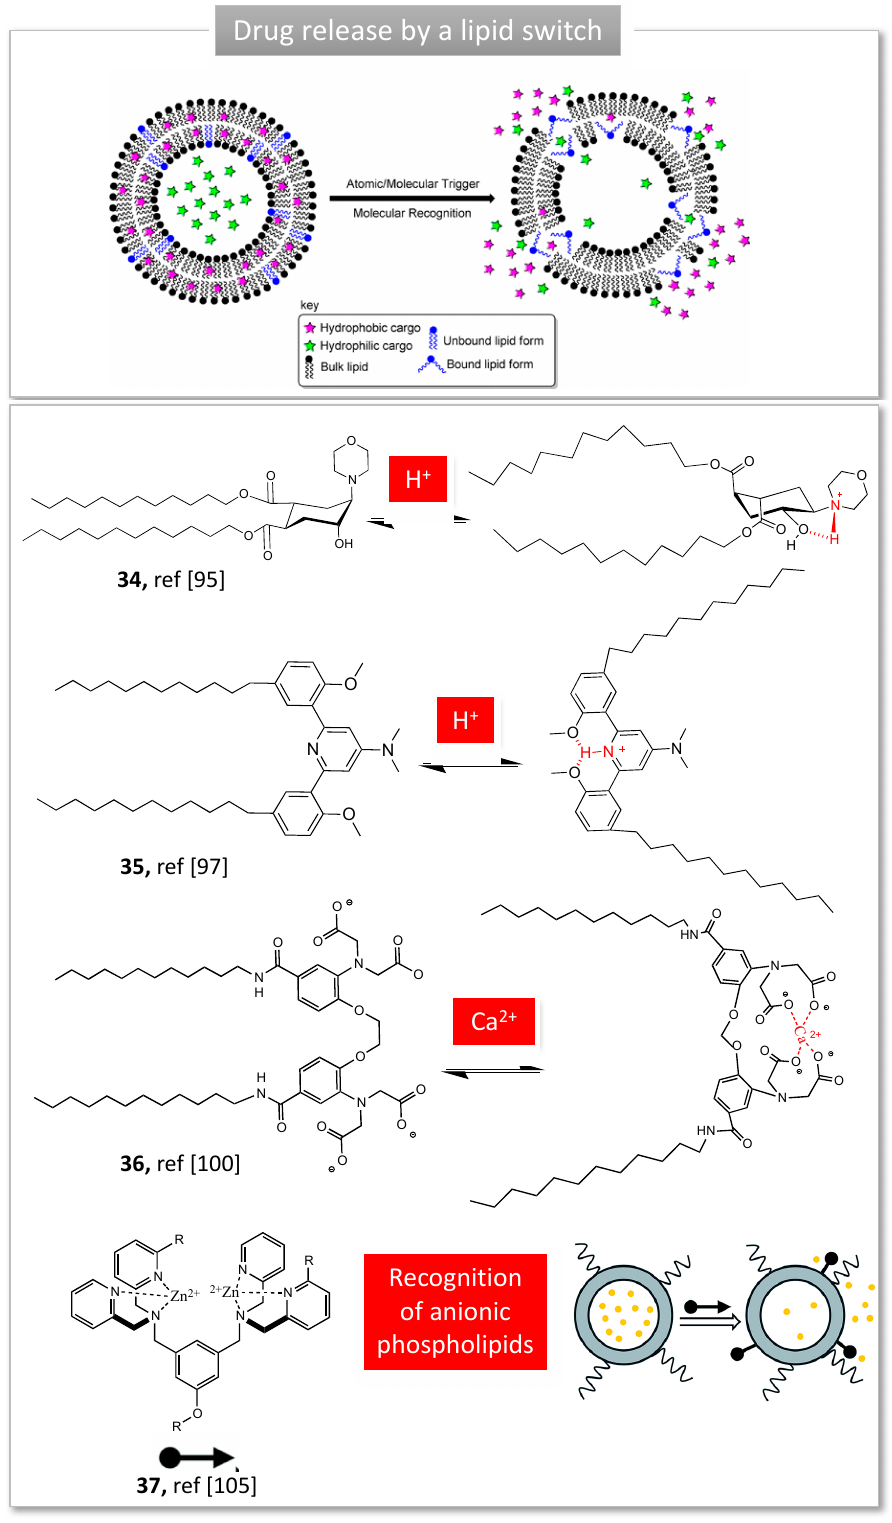
Figure 9. Examples of lipid switches used for stimulus-responsive drug release. Adapted from [89,105].